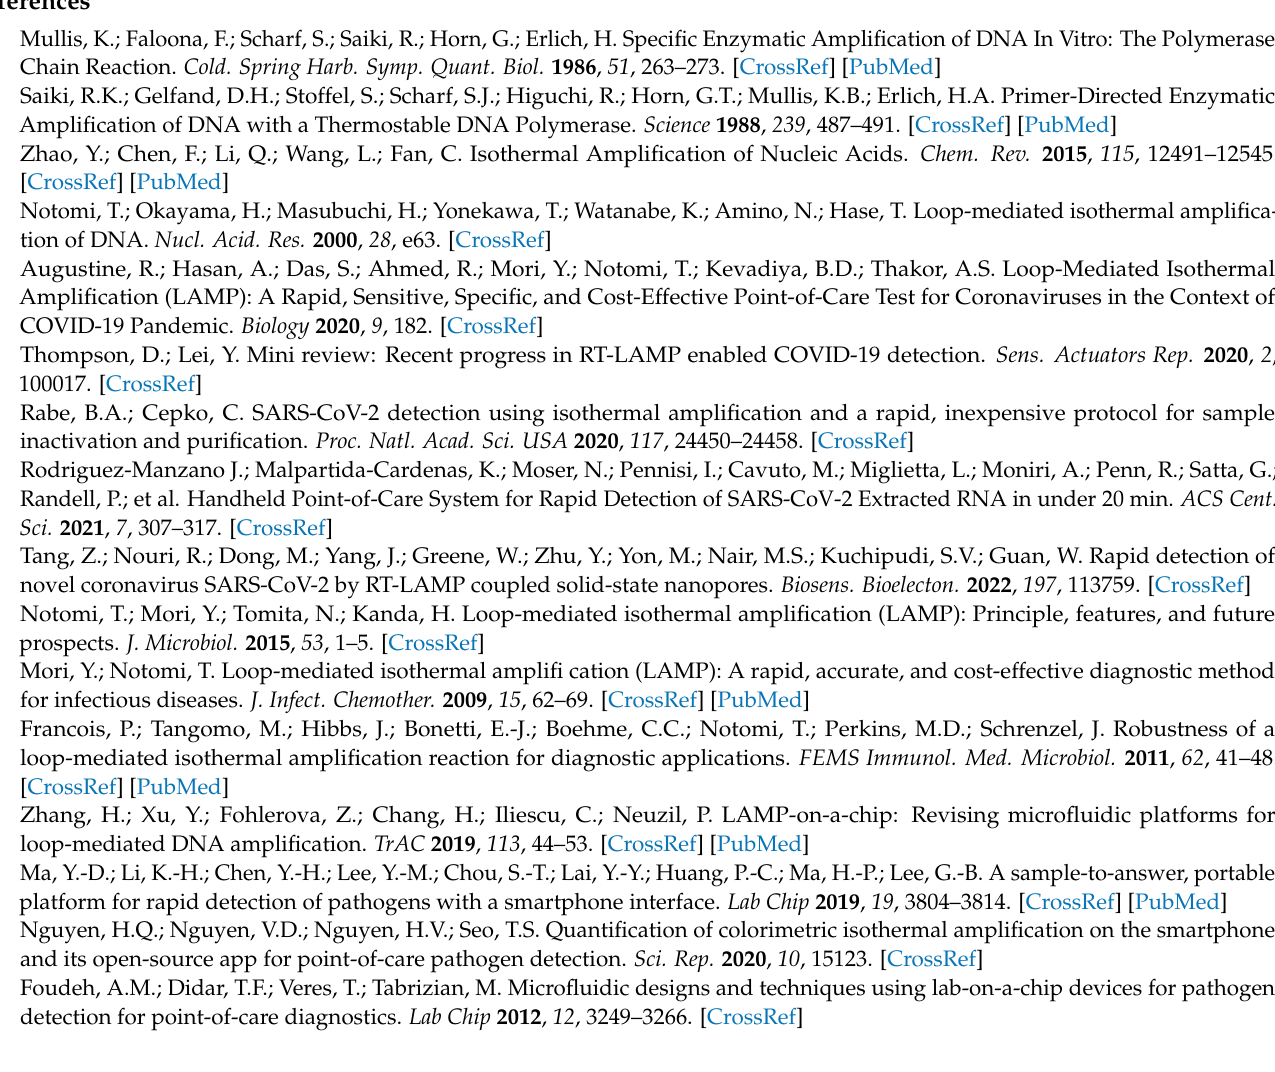
Figure S3: EvaGreen concentration effects on fluorescence measurements, Figure S4: Normalized fluorescence for various dumbbell and primer concentrations, Figure S5: Normalized fluorescence for various dumbbell and dNTP